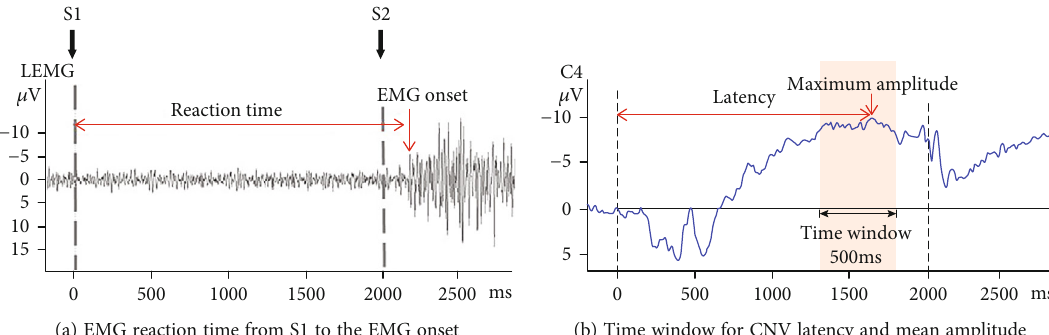
Figure 4: Timing window for signal processing